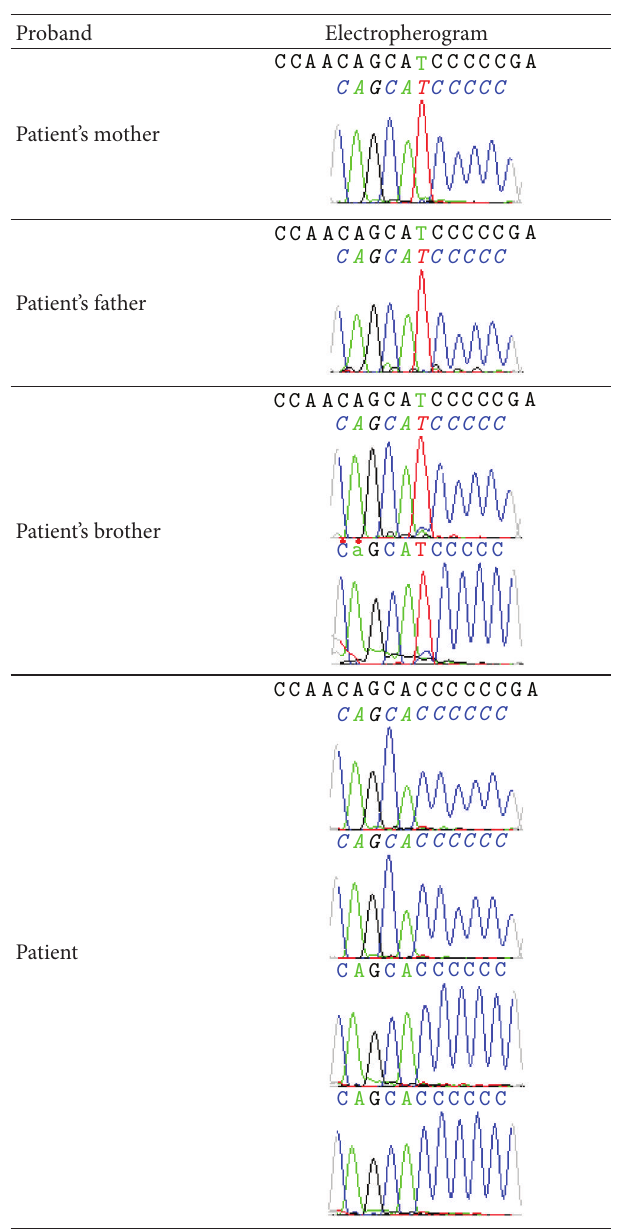
Table 2: Electropherograms showing the silent mutation found (rs2106416) in sequences of mother, father, and brother of